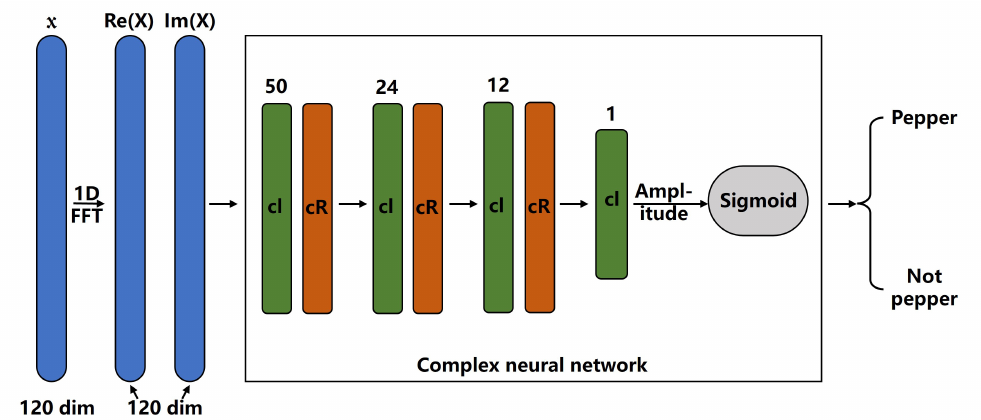
Figure 2. The whole pipeline of our proposed complex model. “cl” and “cR” represent the abbrevia- tion for the complex linear layer and complex ReLU activation function, respectively, and the number on each complex linear layer denotes its number of complex neural